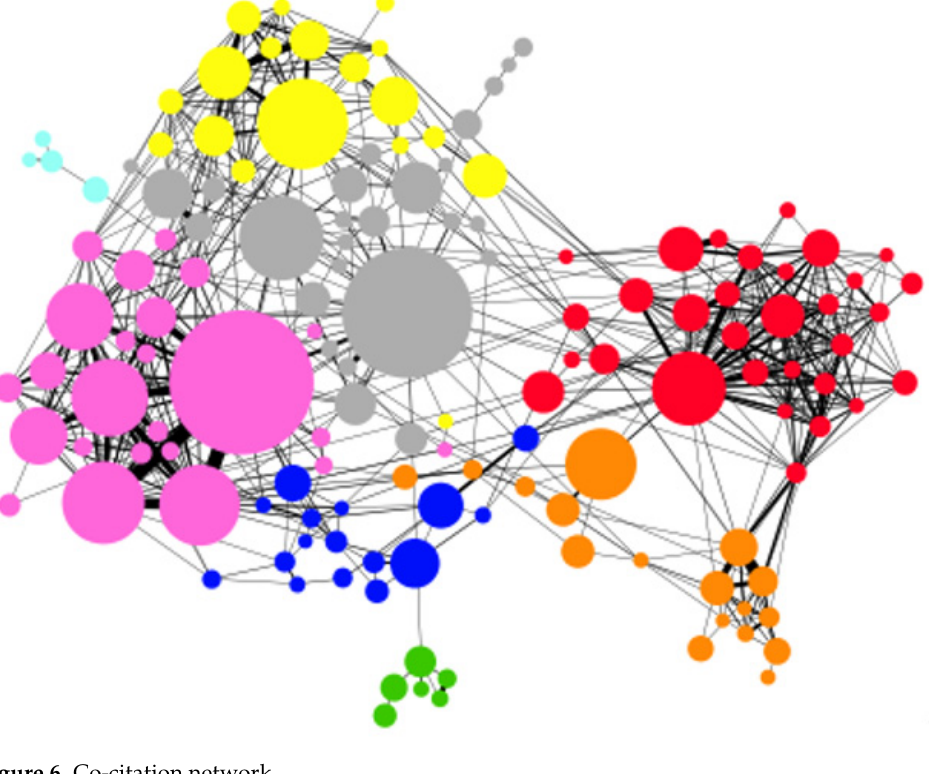
Figure 6. Co-citation network. Table 9. Research focuses and number of publications in co-citation clusters. Table 9. Research focuses and number of publications in co-citation clusters.